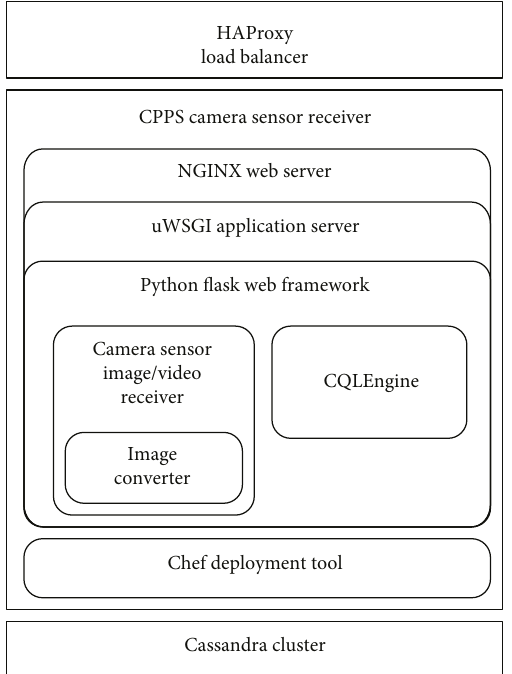
Figure 3: Architecture of a web-based data collector application for sensor image